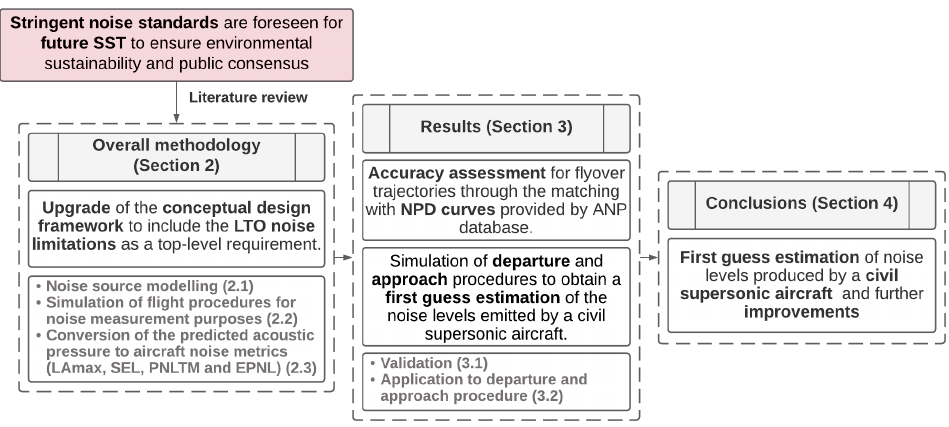
Figure 1. Roadmap of the performed